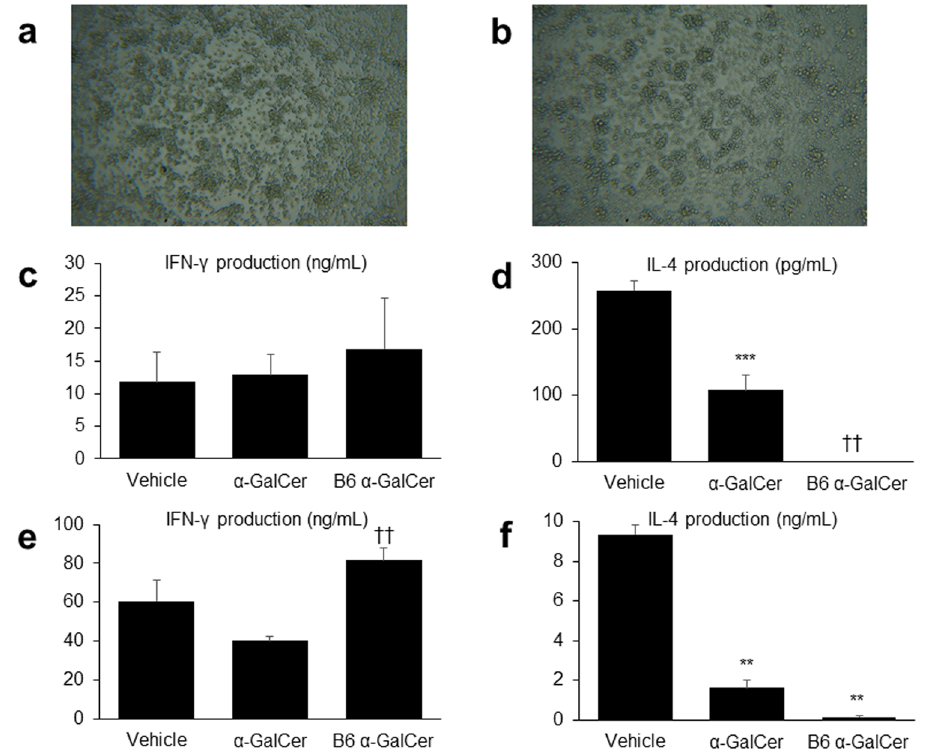
Figure 7. Th2 but not Th1 immune responses are suppressed by repeated alpha-galactosylceramide ( α -GalCer) injections. Microphotographs of liver mononuclear cells (MNCs), stimulated by concanavalin A (ConA) in the ( a ) vehicle and ( b ) α -GalCer groups (original magnification, 100 × ). IFN- γ production and IL-4 production from liver MNCs, stimulated with ( c , d ) ConA or ( e , f ) anti-CD3 antibody for 48 hours in (NZB/NZW) F1 (BWF1) mice treated with α -GalCer or vehicle, and C57BL/6 J (B6) mice treated with α -GalCer ( n = 4–5 in each group). ** p < 0.01, *** p < 0.001 compared with the vehicle group of BWF1 mice. †† p < 0.01 compared with the α -GalCer group of BWF1